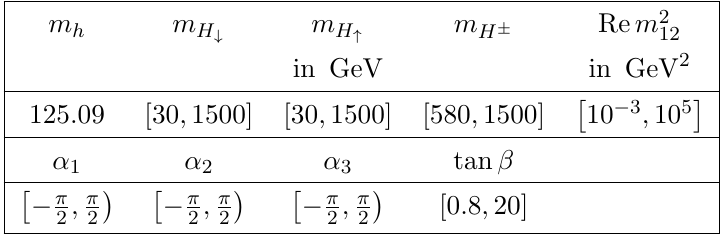
Table 5 . Parameter ranges for the C2HDM T2 input parameters used in ScannerS